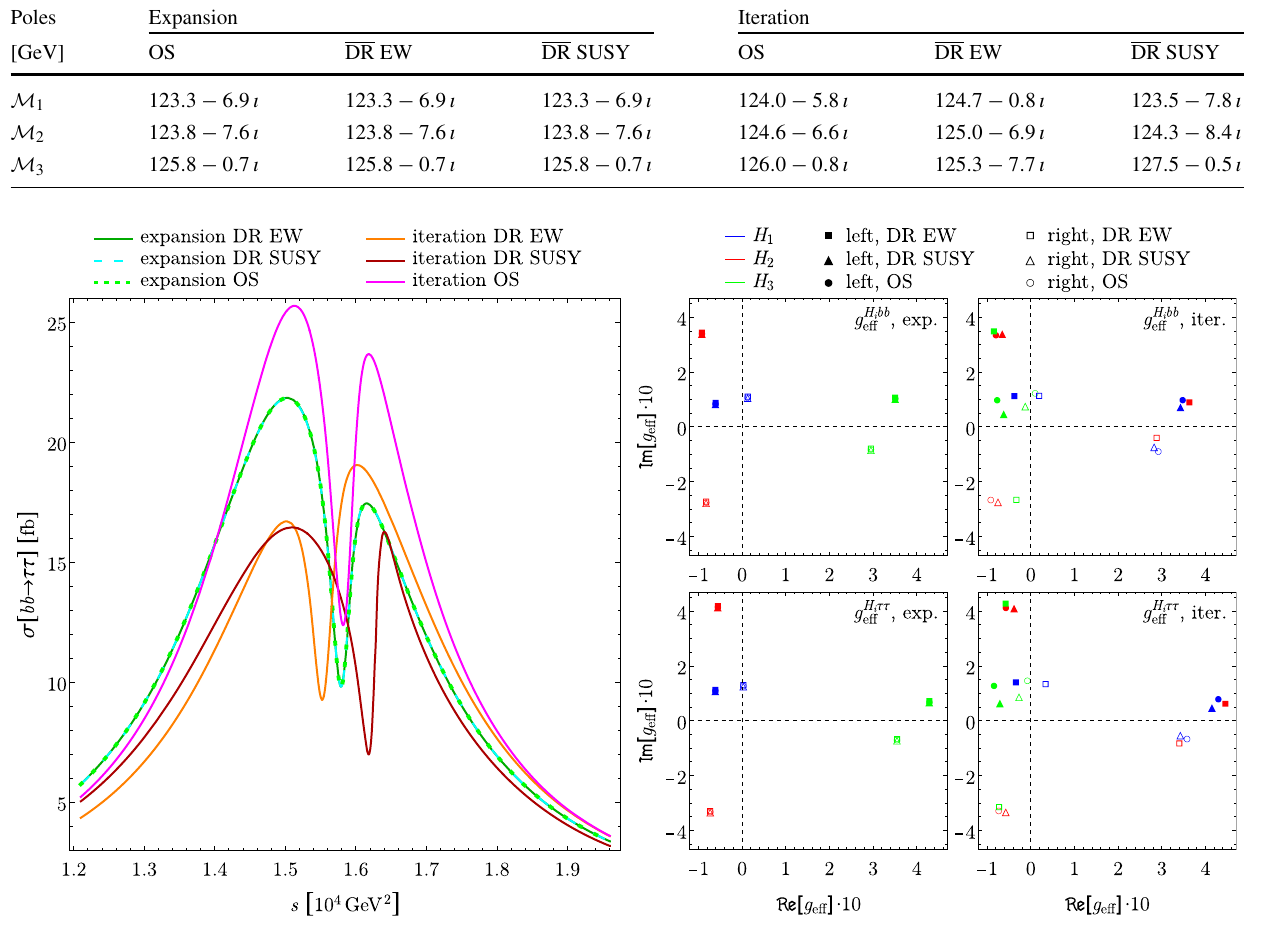
Fig. 10 Fermion scattering in the vicinity of three near-degenerate scalar resonances. Left: cross-section σ [ b ¯ b → τ + τ − ] obtained with poles and couplings in the expansion approach (dark-green, green and cyan, solid and dashed, depending on the scheme for field renormaliza- tion) and in the iterative method with off-shell momenta (solid orange, red and magenta in the DR EW, DR SUSY and OS schemes for fields,